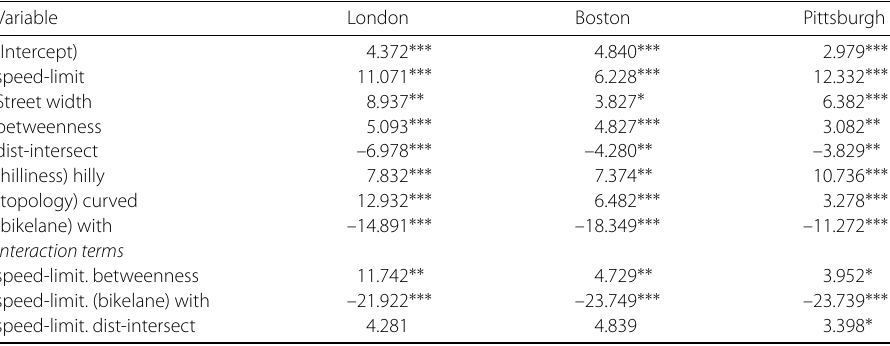
Table 3 Logistic regression coefficients for the risk model built with the datasets from different cities